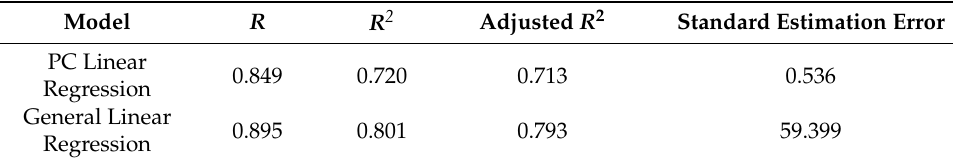
Table 8. Comparison of R 2 and standard estimation error of two